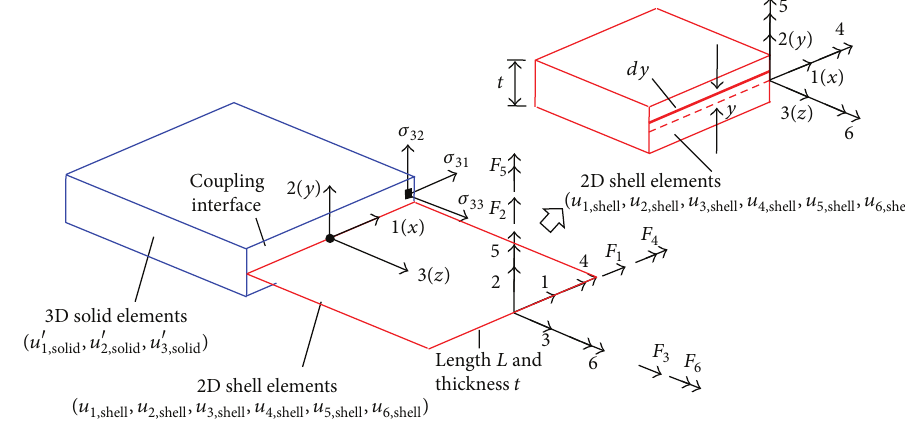
Figure 4: Coupling of 2D elements with 3D elements.